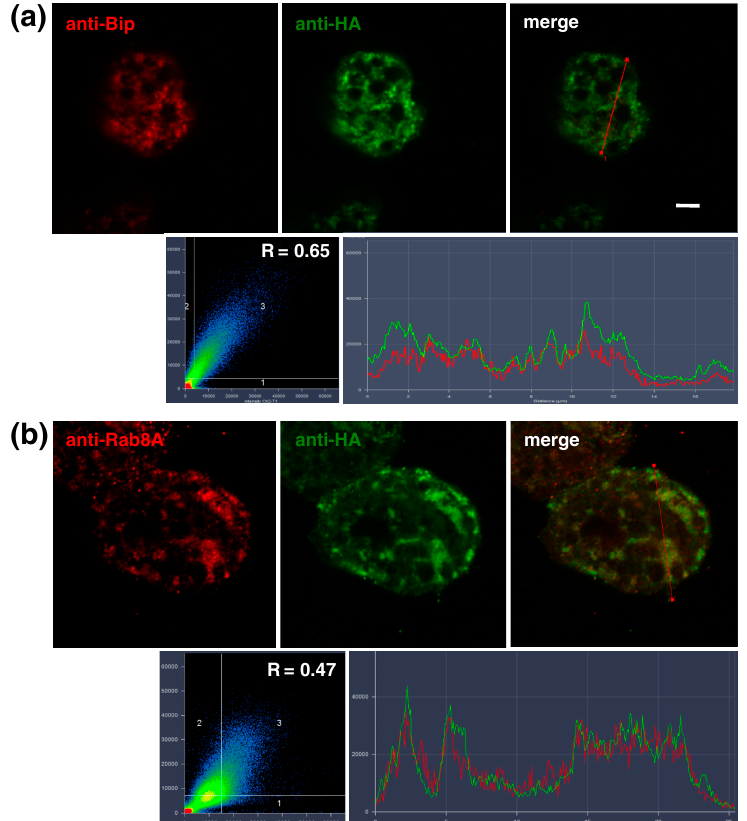
Figure 4. Immunofluorescence assay showing ER localization of overexpressed HA-EhCdc50. HA-EhCdc50 expressing trophozoites were stained with anti-Bip ( a , red), anti-EhRab8A ( b , red) and anti-HA (green) antibodies (top panels) after permeabilization with Triton X100. Histograms of the green and red signal intensities along the line indicated in the merged images are shown in the bottom left panels. Scatter plots of colocalization of the two signals in each pixel are shown in the bottom right panels. R = Pearson’s correlation coefficient. Scale bar, 5 µm.